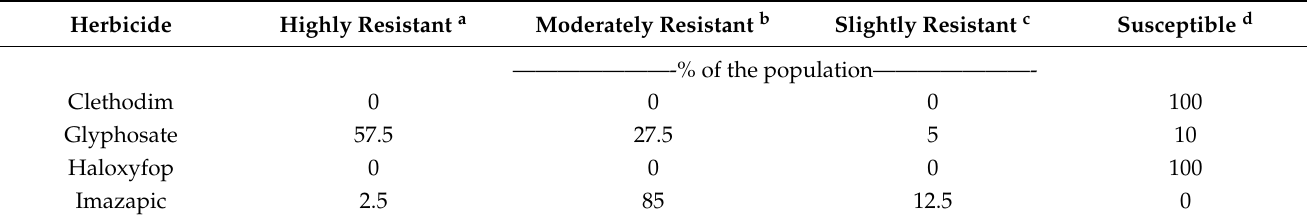
Table 1. Resistance levels of Chloris virgata populations ( n = 40) collected from Queensland, Australia. Herbicide Highly Resistant a Moderately Resistant b Slightly Resistant c Susceptible d ———————-% of the population———————- Clethodim 0 0 0 100 Glyphosate 57.5 27.5 Haloxyfop 0 0 0 100 Imazapic